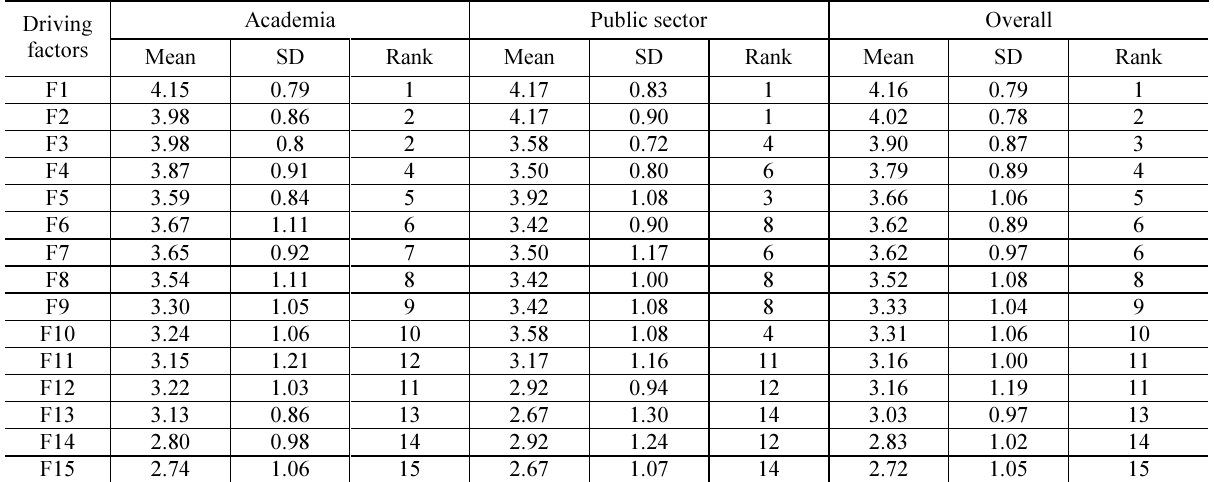
Table 5. The Scores and Rankings of Driving Factors